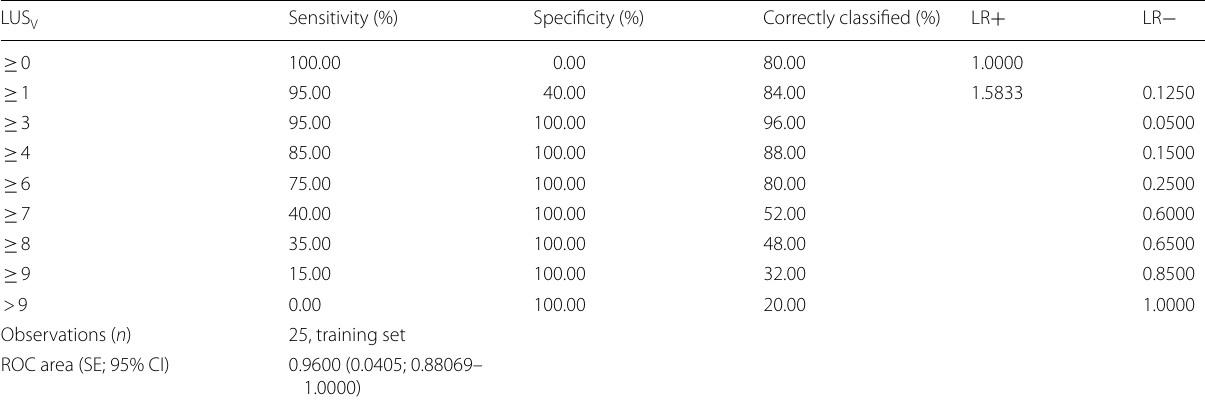
Table 3 Accuracy of prediction of regional LUS characteristic (ROC) analysis in the training